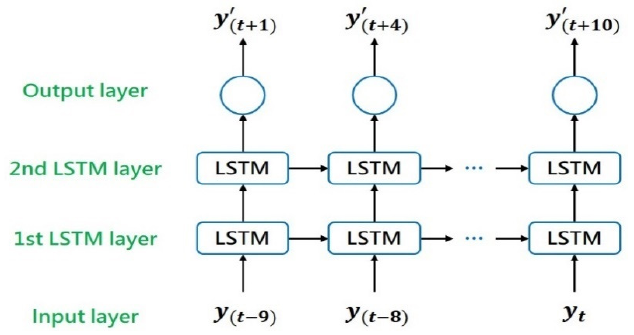
Figure 2. LSTM model with the many-to-one structure.